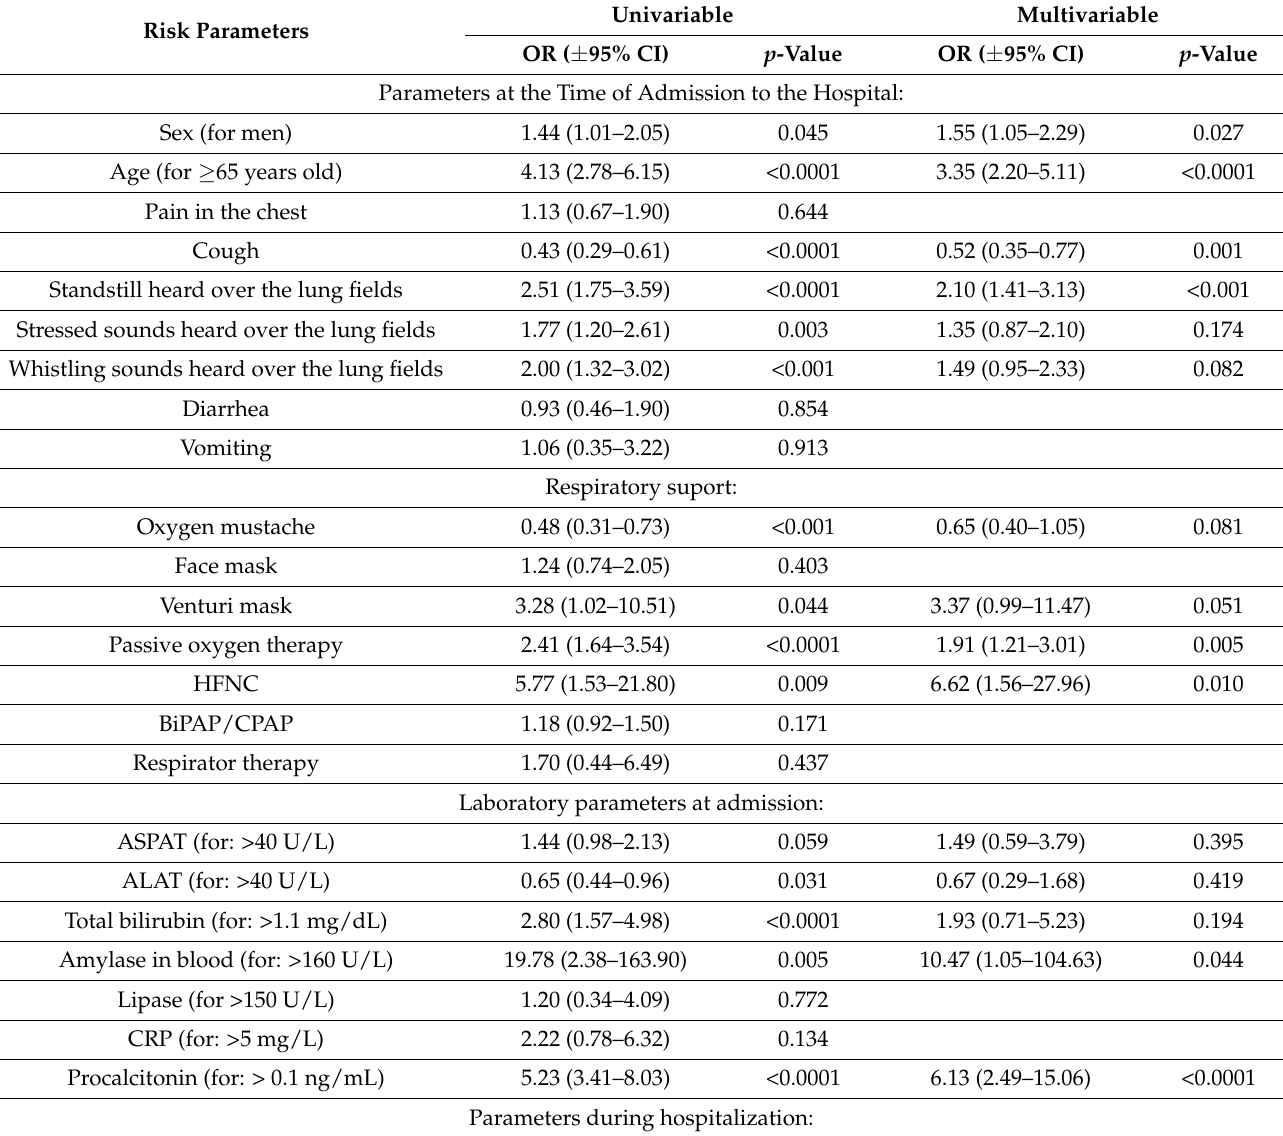
Table 4. Univariable and multivariable logistic regression analysis of selected variables as predictors of death in group of patients with dyspnea (Group B; n =